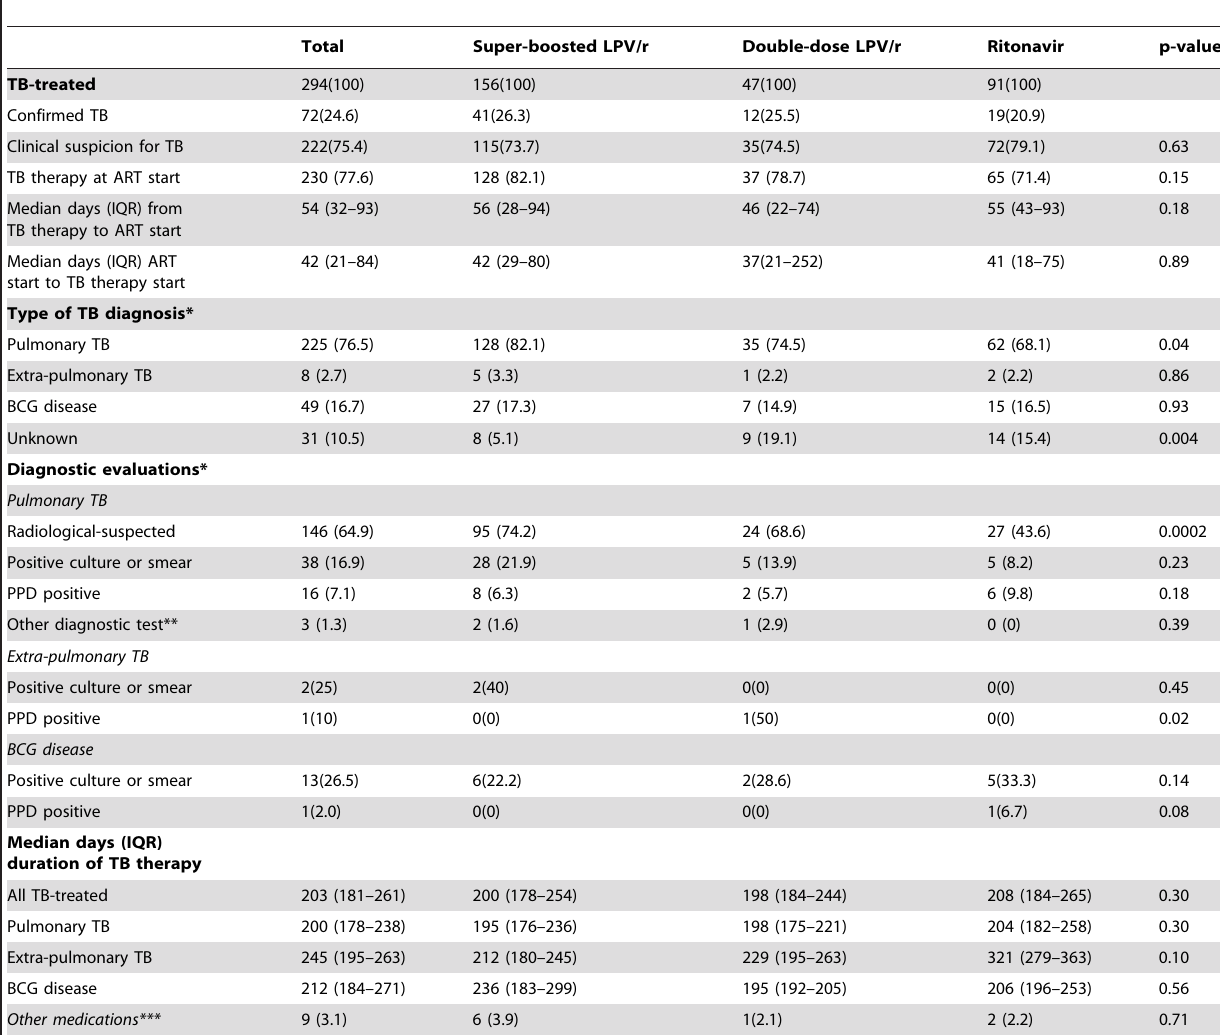
Table 1. Characteristics of children who initiated TB treatment by modification made to antiretroviral treatment (ART)